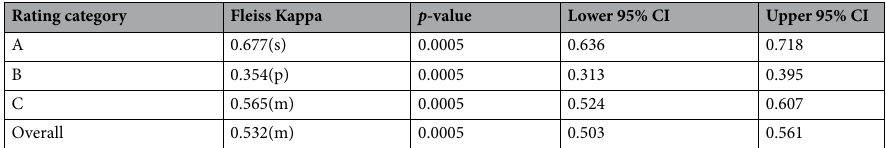
Table 4. Fleiss Kappa among all reviewers. 0.41–0.60 is considered moderate, 0.61–0.80 is considered substantial, and more than 0.80 is considered excellent 33,34 .